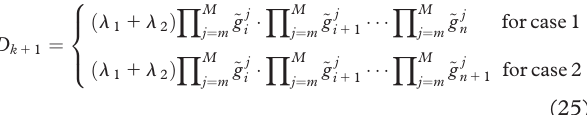
The optimal objective cost for the segment between stop